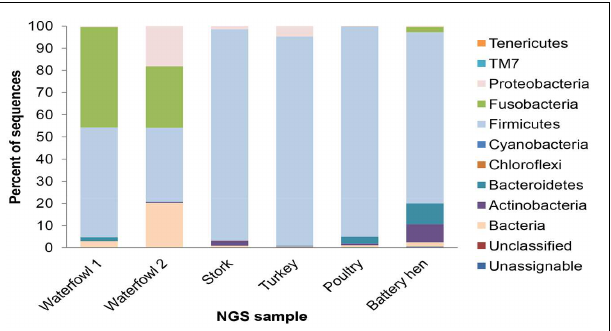
FIGURE 1 | Taxonomic distribution of associated bacteria of tested fecal avian samples: waterfowl, stork, turkey, poultry, and battery hen given in percents. Most OTUs were assigned to the phyla of Firmicutes , Proteobacteria, and Fusobacteria .